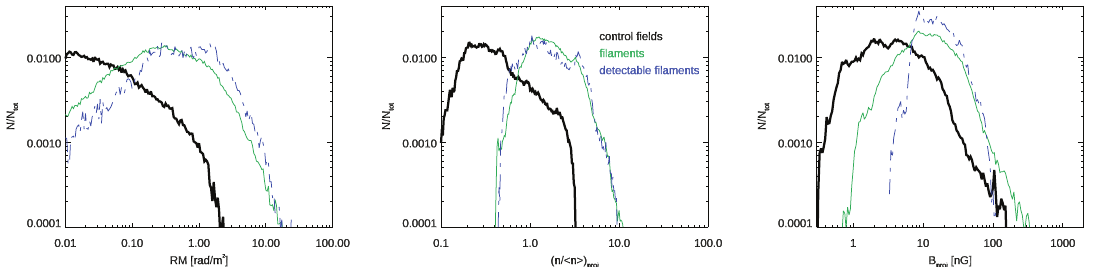
Figure 4. Distributions of RMs, projected mean gas density and mean magnetic field strength for all control fields and filaments considered in our datasets (primordial model, including all analyzed lines of sight). The additional dot-dashed lines show the distributions of the same fields limited to the 4 most detectable filaments in Figure